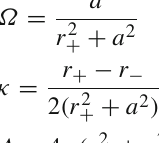
test fields. The absorption of modes with arbitrarily low val- ues of ω is allowed for which Δ fin diverges to minus